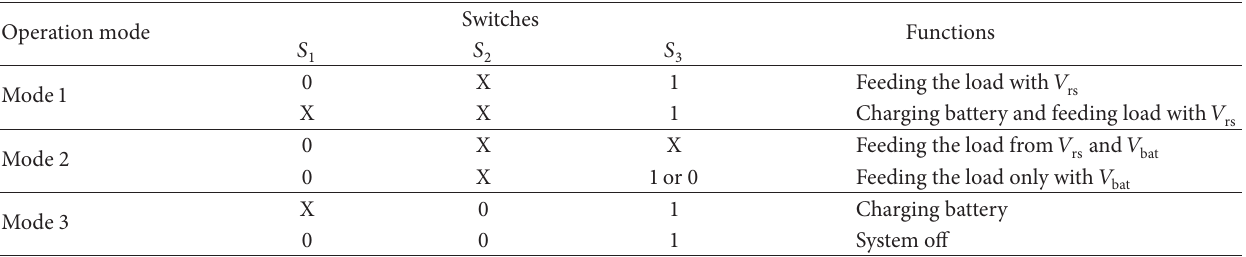
Table 1: Switching states of the converter.